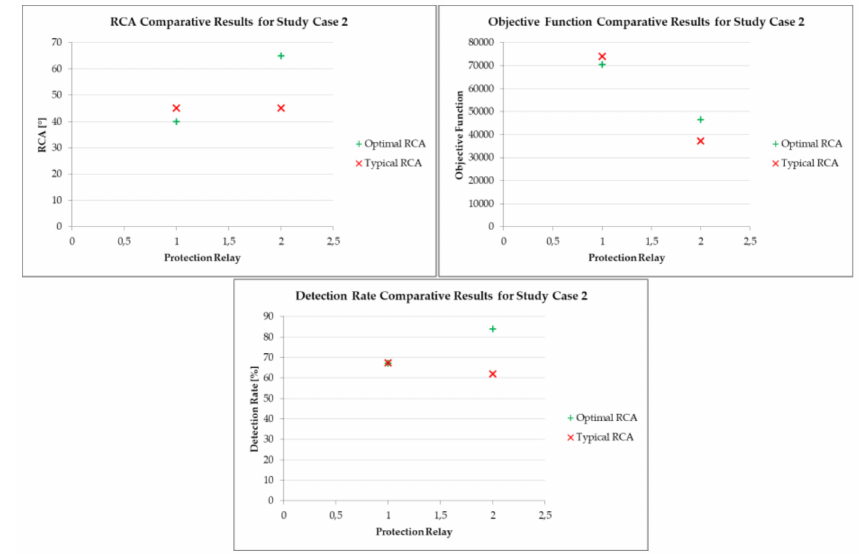
Figure 16. Comparative results for the evaluation of polarization on the directional phase overcurrent element (ANSI 67) in the protection relays of Study Case